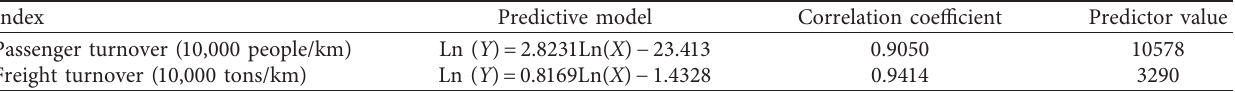
Figure 8: Highway passenger and freight turnover in Yuanba district over the years. Table 6: Forecast models and index values of highway passenger turnover and freight turnover over the years.